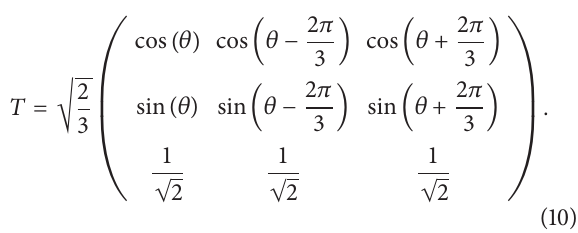
Figure 7: The power output from two WECs in real sea trials are displayed [21]. By connecting several units in parallel, the total output power variance can be